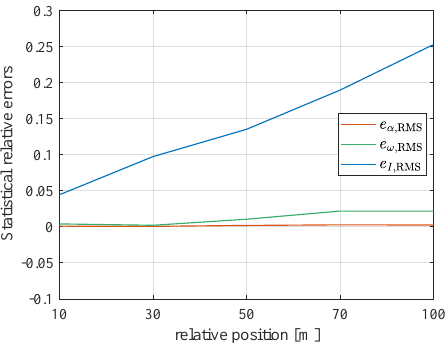
Figure 11. The statistical RMS relative errors of the attitude and the inertial parameters of the object under different relative distance || r ||